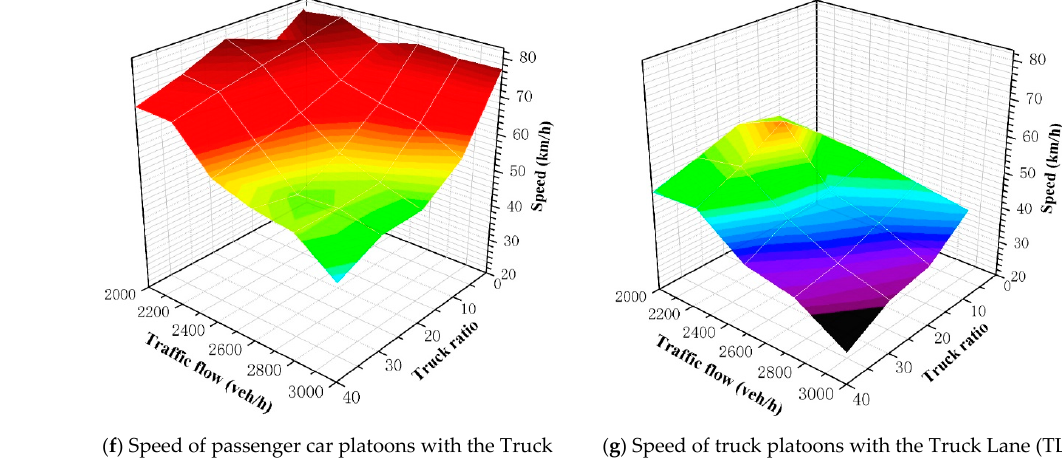
Figure 5. Data obtained by simulation of different contraflow strategy schemes. Table 3. Tra ffi c scheme recommendation for evacuation using the contraflow